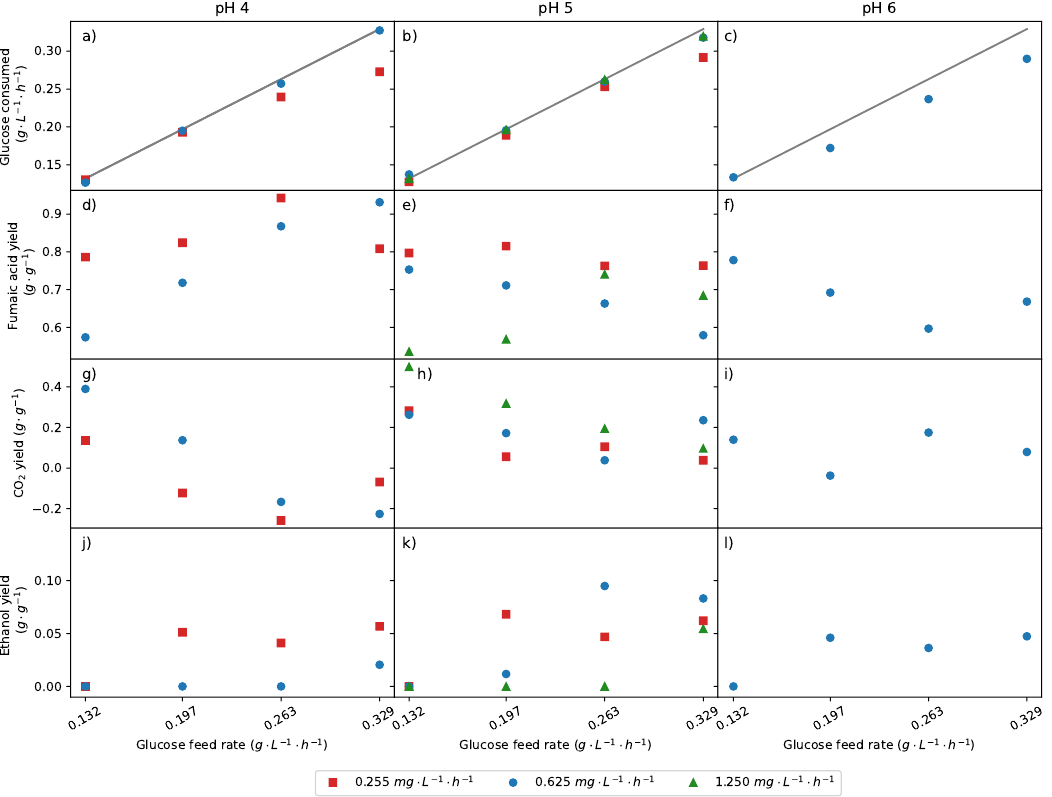
Figure 2. The effect of pH and the urea addition rate on glucose consumption and distribution. ( a – c ) A parity plot between the glucose feed and glucose consumed. ( d – f ) The yield of fumaric acid from glucose. ( g – i ) The yield of CO 2 from glucose. ( j – l ) The yield of ethanol from glucose. As indicated in Table 1, repeat experiments were conducted, and the average values of the two experiments are presented. For the conditions that were not repeated, single fermentation values were